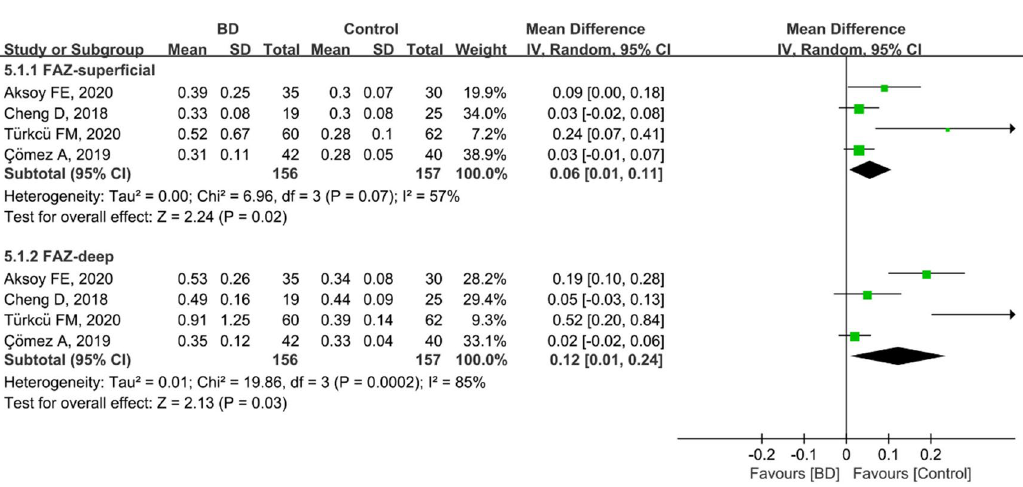
Figure 10. Forest plot analysis of parafoveal superficial and deep vessel density in non-ocular BD patients and controls.